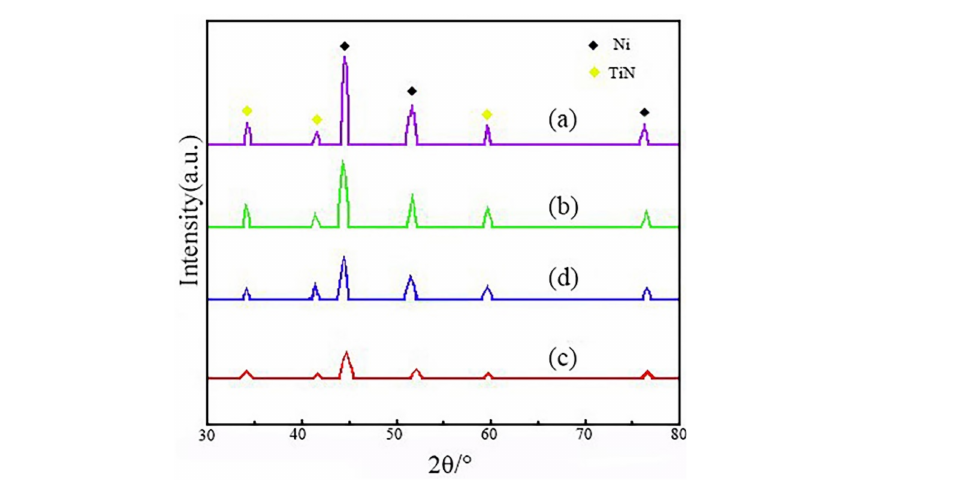
Figure 5. XRD patterns of Ni–TiN coatings deposited at disparate nozzle diameters: ( a ) Nf = Φ 3 mm, ( b ) Nf = Φ 5 mm, ( c ) Nf = Φ 7 mm, ( d ) Nf = Φ 9